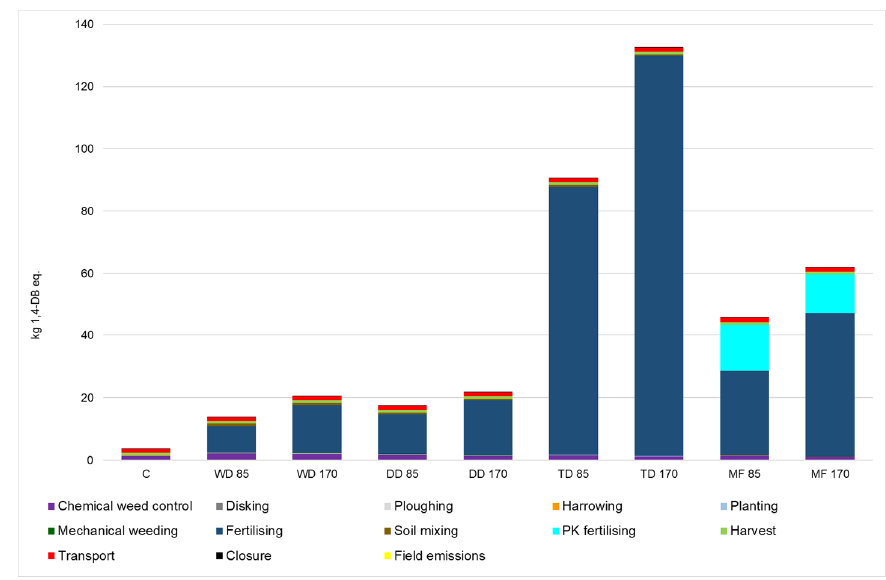
Figure 7. Human toxicity per 1 Mg d.m. of miscanthus in different fertilisation treatments.